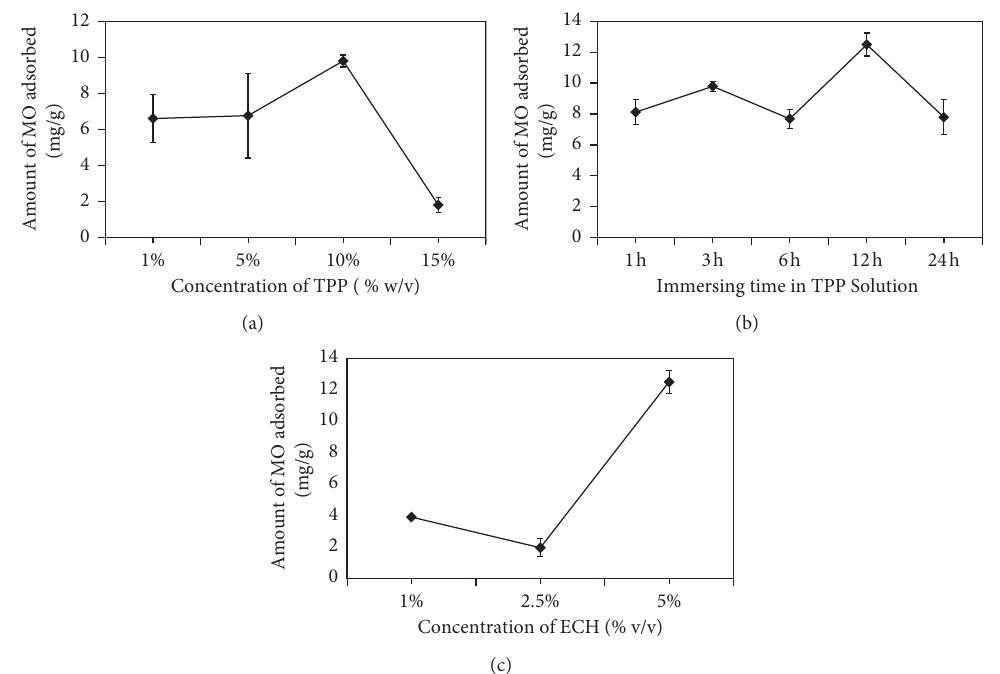
Figure 3: Effect of TPP concentration at conditions of 12 h immersing time and ECH 5% (v/v) (a), immersing time of chitosan in TPP solution at conditions of TPP 10% (w/v) and ECH 5% (v/v) (b), and concentration of ECH at conditions of 12h immersing time in TPP 10% (w/v) (c) for the preparation of the cross-linked chitosan beads. Sample: 50mL methyl orange 20 ppm; cross-linked chitosan beads mass: 0.02g; stirring rate � 100rpm; pH